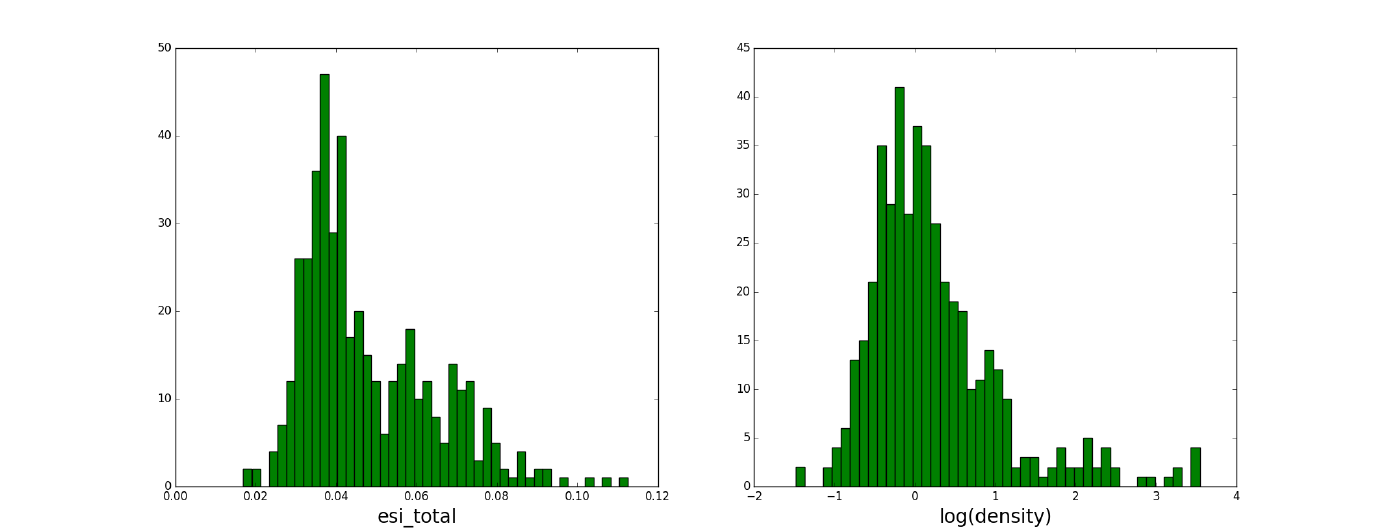
Figure 5. The histograms for the density (expressed in gm / cm 3 ) and the total ESI shown individually to see the general trend of the